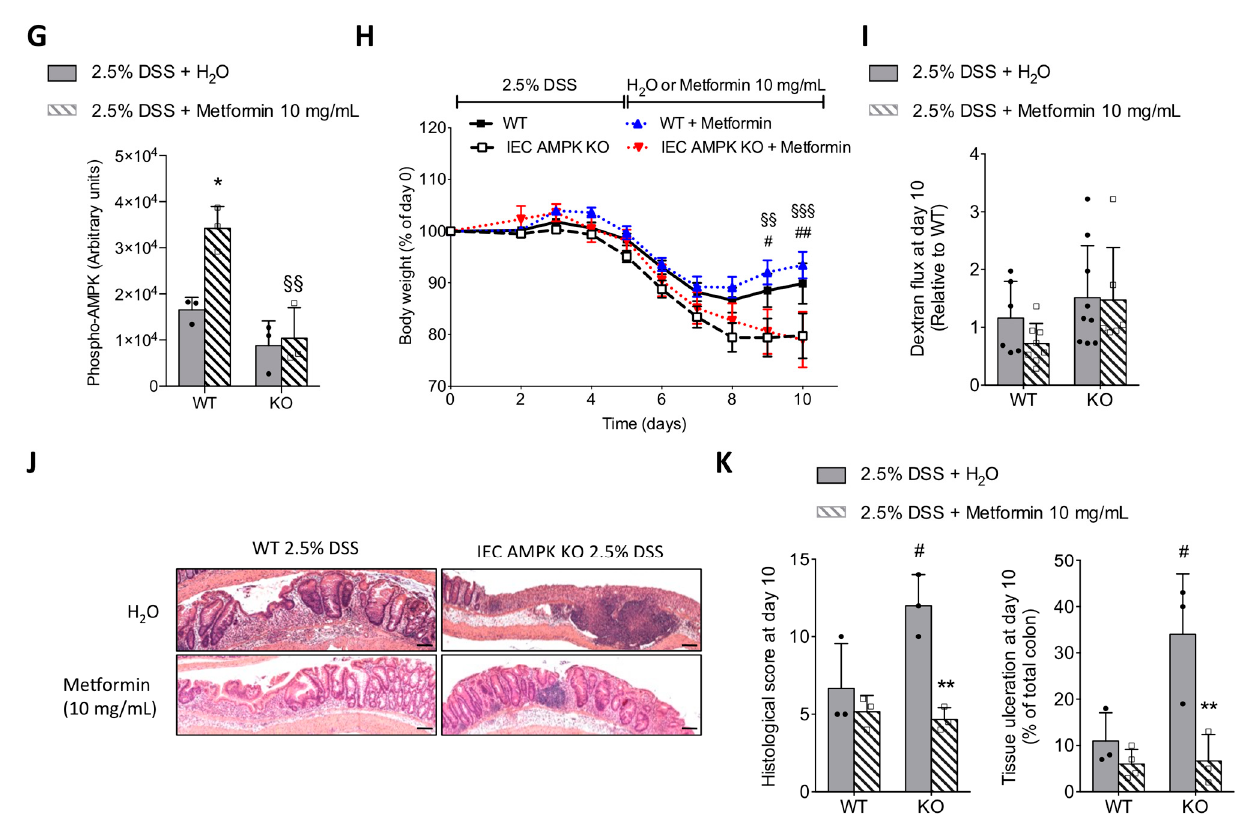
Figure 6. Effect of metformin treatment during the recovery phase on the recovery from DSS-induced colitis in WT and IEC AMPK KO mice. ( A ) Experimental timeline for mice treated with 2.5% DSS in drinking water for five consecutive days, followed by four days of metformin (2 mg/mL) in drinking water or regular water. ( B ) Changes in body weight ( n = 6–9 mice/group). ( C ) In vivo intestinal epithelial permeability on day 9. Dextran flux was determined by measuring the amount of 4 kDa TRITC-dextran in the plasma 4 h after gavage. Data are presented as mean dextran flux fold change relative to respective control mice ( n = 6–9 mice/group). ( D ) Lipocalin-2 (Lcn-2) levels in feces from WT and IEC AMPK KO mice during the course of DSS-induced colitis and treatment with metformin (2 mg/mL) in drinking water ( n = 6–9 mice/group). ( E ) Experimental timeline for mice treated with 2.5% DSS in drinking water for five consecutive days, followed by five days of metformin (10 mg/mL) in drinking water or regular water. ( F ) Levels of total AMPK α and AMPK α -Thr172 phosphorylation in full-thickness colon biopsies from WT and IEC AMPK KO mice on metformin (10 mg/mL) in drinking water or regular water ( n = 3 mice/group). ( G ) Quantification of AMPK α -Thr172 phosphorylation in Western blot from three replicates. ( H ) Changes in body weight ( n = 6–9 mice/group). ( I ) In vivo intestinal epithelial permeability on day 10. Dextran flux was determined by measuring the amount of 4 kDa TRITC-dextran in the plasma 4 h after gavage. Data are presented as mean dextran flux fold change relative to respective control mice ( n = 6–9 mice/group). ( J ) Representative images of H&E-stained colon sections on day 10 from IEC AMPK KO and WT DSS-treated mice administrated H 2 O or 10 mg/mL metformin during the recovery phase. Pictures are representative of 3–4 mice/group. Scale bars = 50 µm. ( K ) Histological damage score and quantification of percentage of ulceration related to total colon length in IEC AMPK KO and WT mice upon DSS-induced epithelial damage and metformin (10 mg/mL) treatment ( n = 3–4 mice/group). Data are expressed as means ± SD. Statistical analysis was performed by one-way ANOVA or two-way ANOVA with Bonferroni post hoc test; * p < 0.05 and ** p < 0.01 indicate a significant difference relative to the untreated condition; # p < 0.05, ## p < 0.01 and ### p < 0.001 indicate a significant difference between genotype and §§ p < 0.01 and §§§ p < 0.001 indicate a significant difference between metformin-treated mice.